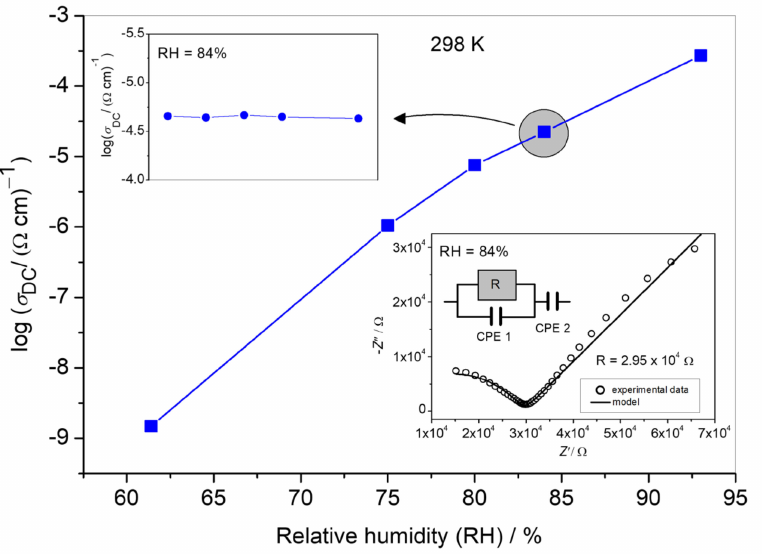
Figure 6. The proton conductivity of 1 as a function of relative humidity (RH) at room temperature. The inset in the left corner shows the time-dependent proton conductivity of 1 at 84% RH. The inset in the right corner shows the Nyquist plot of 1 measured at RH = 84%. The impedance semicircle corresponds to the bulk response of the sample, and low-frequency spur is related to the blocking of protons at the surface of the electrodes. The corresponding equivalent electrical circuit consists of a parallel combination of resistor and constant phase element (CPE 1), which models the bulk response, and an additional constant phase element (CPE 2) in series, which is related to the spur. The Nyquist plots of 1 in other RH conditions are given in Figure